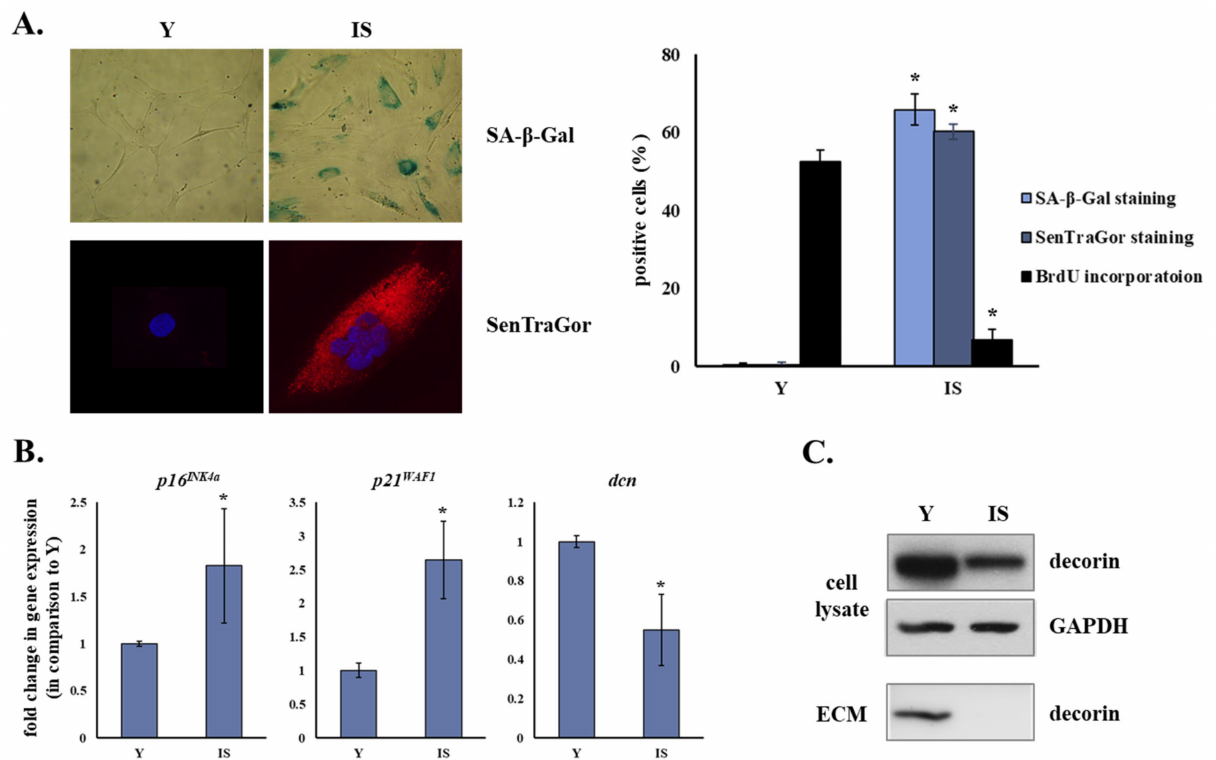
Figure 1. Ionizing radiation leads to the premature senescence of human breast stromal fibroblasts, characterized by the down-regulation of the small leucine-rich proteoglycan decorin. Young (Y) and ionizing radiation-induced senescent (IS) human breast stromal fibroblasts were grown in DMEM containing 10% ( v / v ) FBS before fixation and staining for β galactosidase activity, lipofuscin accumulation and BrdU incorporation ( A ), RNA extraction and gene expression analysis ( B ) and protein or extracellular matrix (ECM) extraction and Western blot analysis ( C ). Glyceraldehyde-3-phosphate dehydrogenase (GAPDH) served as the reference gene in the RT-qPCR analysis and as the loading control in the Western blot analysis of cell lysates. ECM extracts were loaded based on equal cell number of the ECM-producing cells. In the graphs, means ± standard deviations from three and four independent experiments for ( A , B ), respectively, are depicted. Asterisks (*) represent statistically significant differences in comparison to Y (Student’s t test, p < 0.05). SA- β -Gal staining, SenTraGor staining and Western blot analyses for decorin were repeated three times and a representative experiment is presented here. dcn: